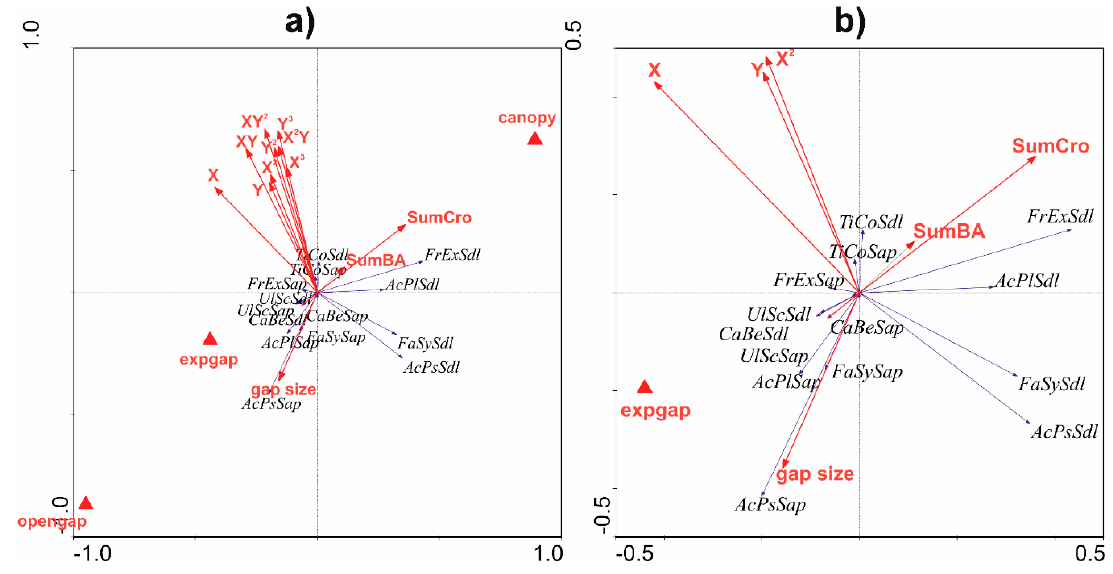
Figure 6. Graphical output of linear direct gradient analysis (redundancy analysis, RDA); ( b ) is extension of view on ( a ). Sdl—seedlings, Sap—saplings, AcPs— A. pseudpolatanus , AcPl— A. platanoides , FrEx— F. excelsior , FaSy— F. sylvatica , TiCo— T. cordata , UlSc— U. scabra , CaBe— C. betulus ,